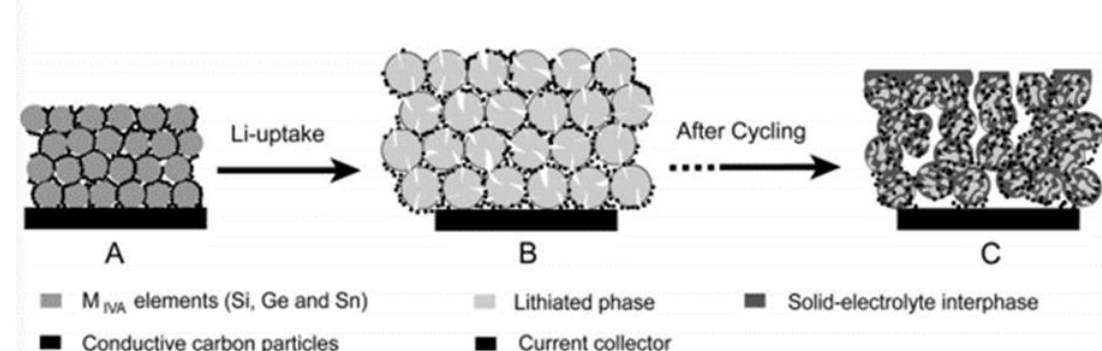
Figure 3. Structure destruction of silicon nanoparticles lose electrical contact during cycles due to stress caused by volumetric effects [19]. Reprinted with permission from [19]. Copyright 2013 John Wiley and Sons.